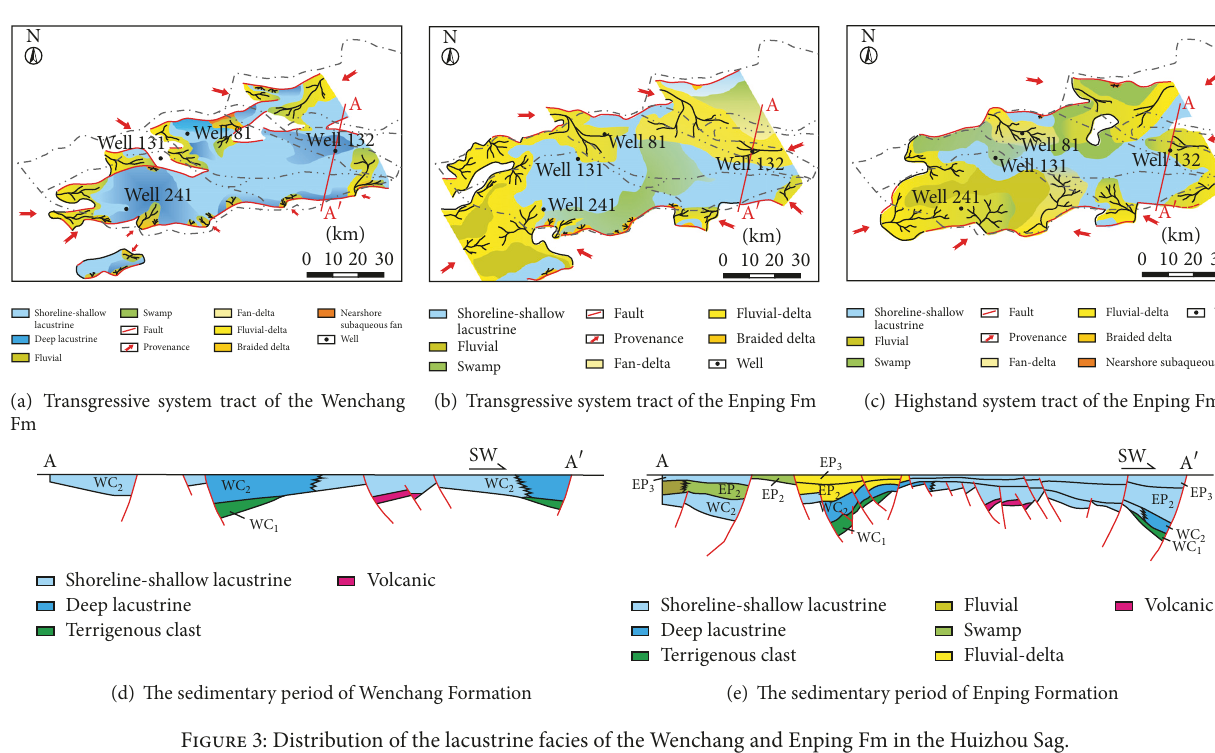
Figure 3: Distribution of the lacustrine facies of the Wenchang and Enping Fm in the Huizhou Sag. Table 1: The percentage of argillaceous source rock in the Huizhou Sag (HZS).